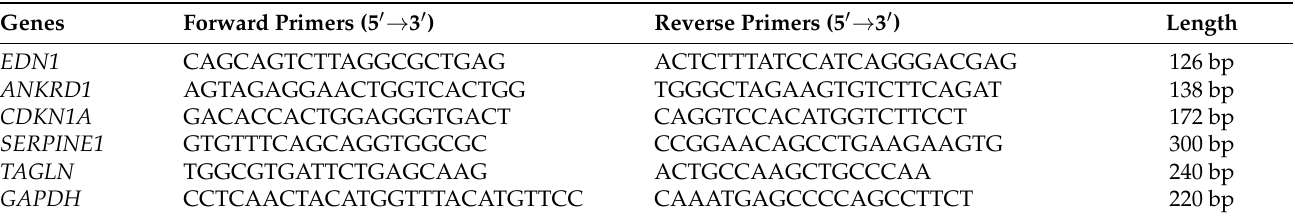
Table 1. Primer information for senescence-related